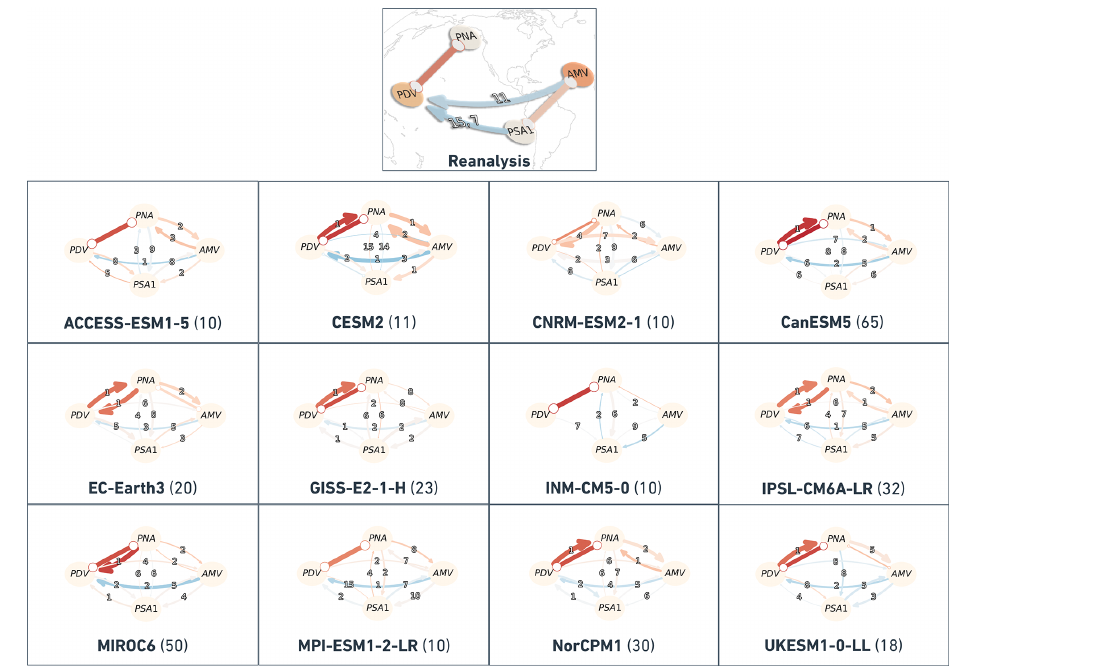
Figure A1. Similar to Fig. 7 but for the 12 CMIP6 models during the complete 1900–2014 period . Each panel has a label stating the model name and the number of ensemble members between parentheses. The auto-MCI values were not taken into consideration.